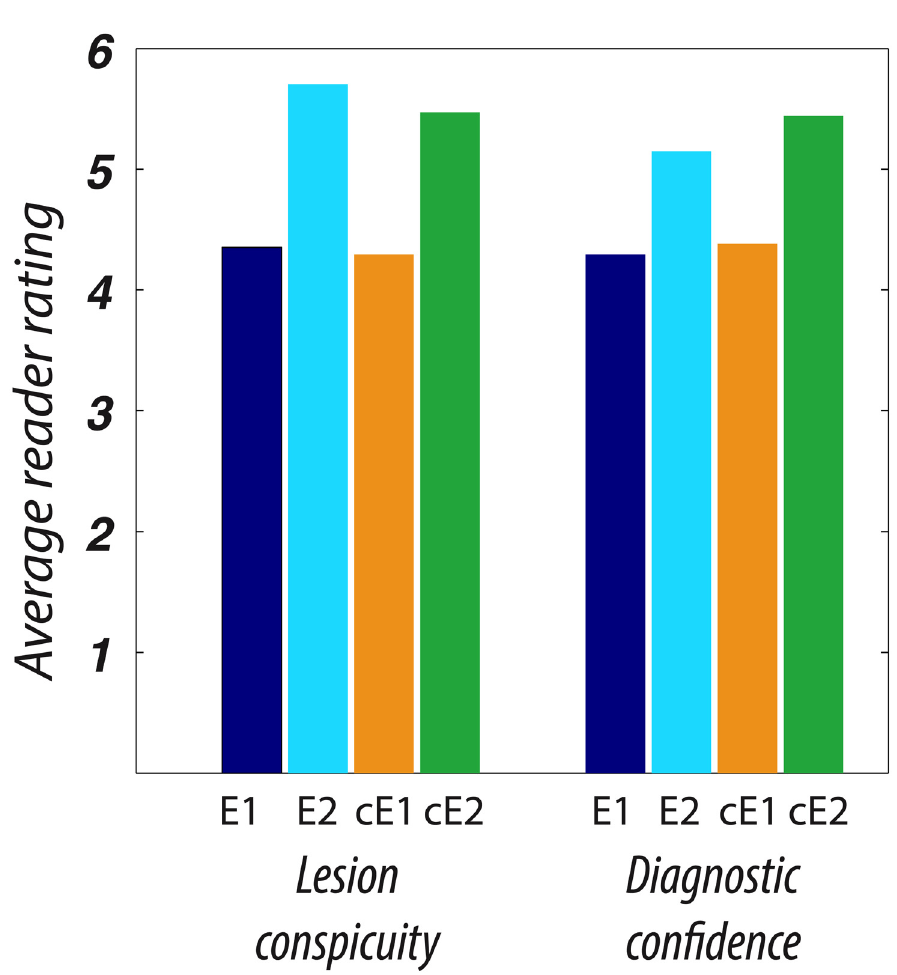
Fig 4. Stacked bar graph showing the grade value and frequency of Readers ’ A and B assessment of lesion conspicuity and diagnostic confidence for Echo1 and Echo2 and their intensity corrected variants (cEcho1 and cEcho2) for patients that had reduced